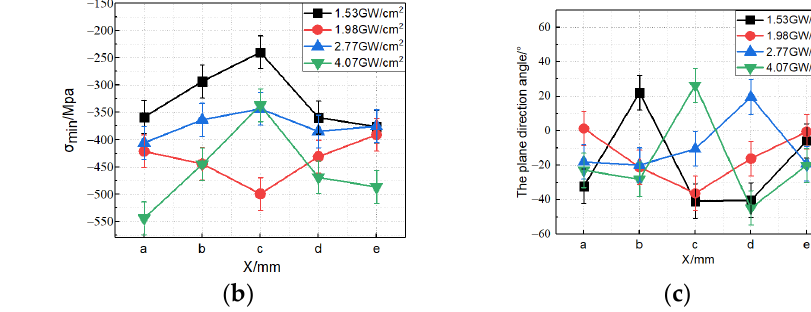
Figure 6. Distributions of residual principal stresses produced by different laser power densities: ( a )